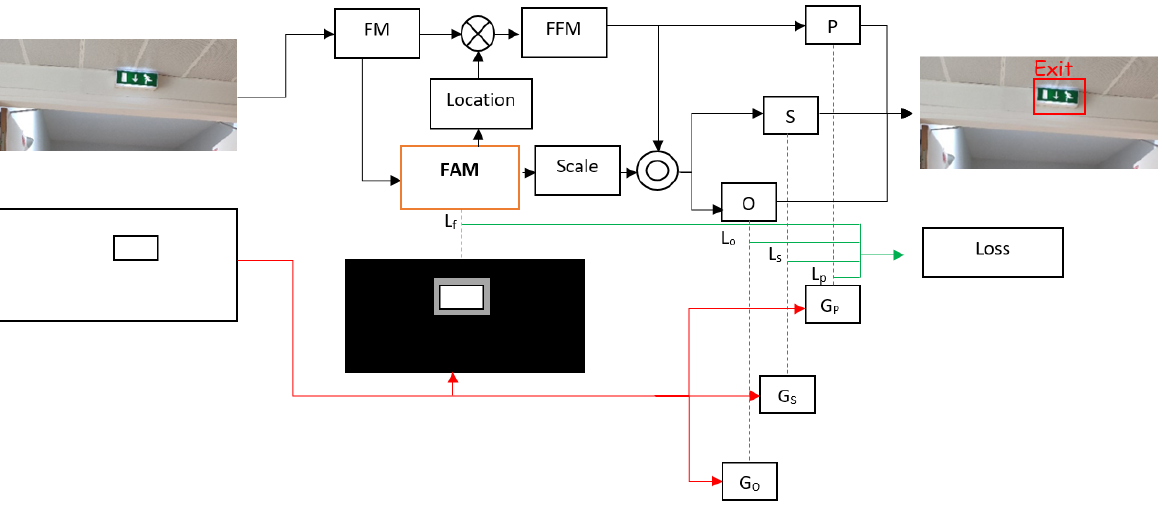
Figure 4. Training workflow of the proposed FAM-centerNet.